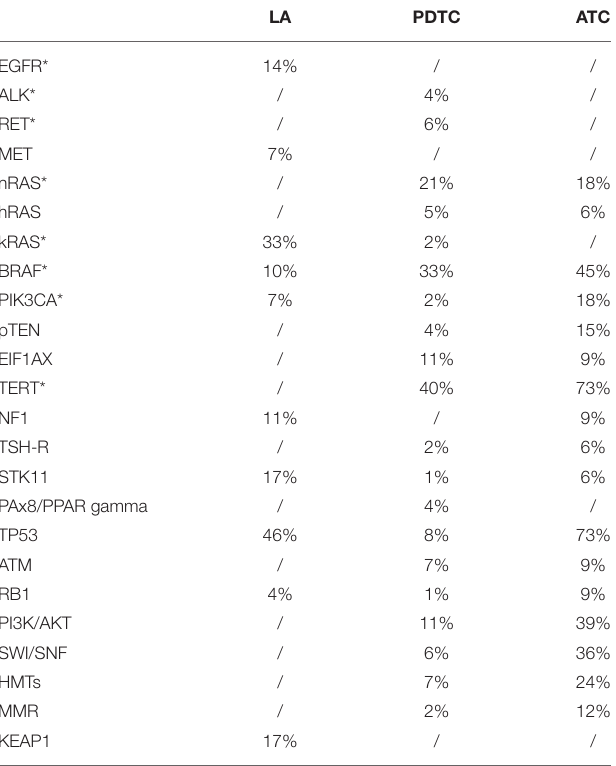
TABLE 1 | Genetic mutations of LA, PDTC, and